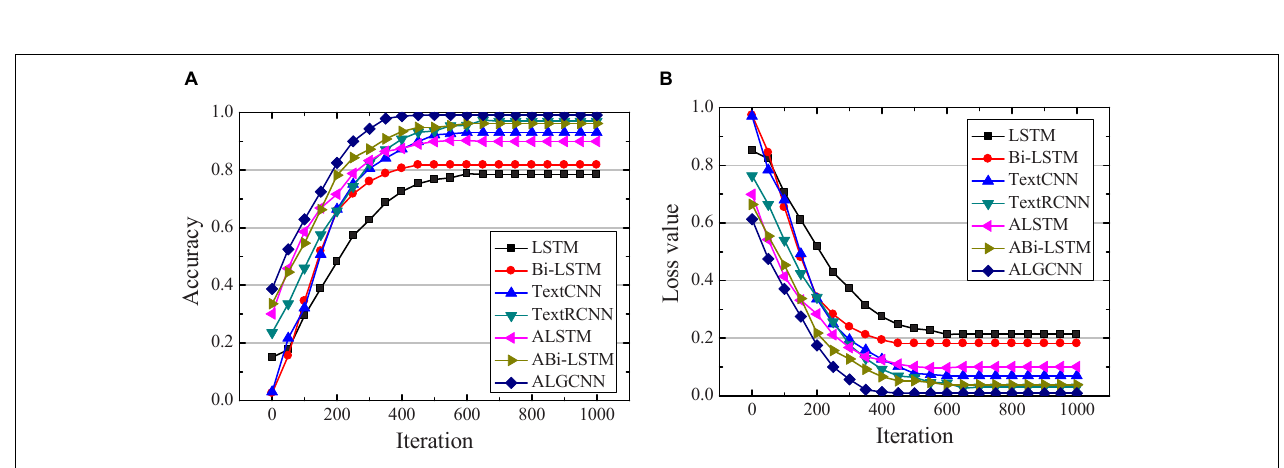
FIGURE 5 | Comparison of classification performance of different models on the MPQA data set. (A) Is the comparison on classification accuracy; (B) is the comparison of classification loss value.